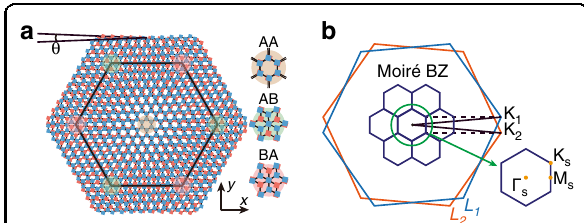
Fig. 1 Lattices and Brillouin zones (BZs) of generic twisted bilayer systems. a Schematic of general twisted bilayer systems with the twist angle θ , where the largest black hexagon denotes moiré superlattices including AA and AB/BA stacked lattices. Blue (red) dots represent the sites in L 1 ( L 2 ). b Schematic of BZs. Sky blue and red hexagons represent fi rst BZs for L 1 and L 2 while black hexagons represent moiré BZs